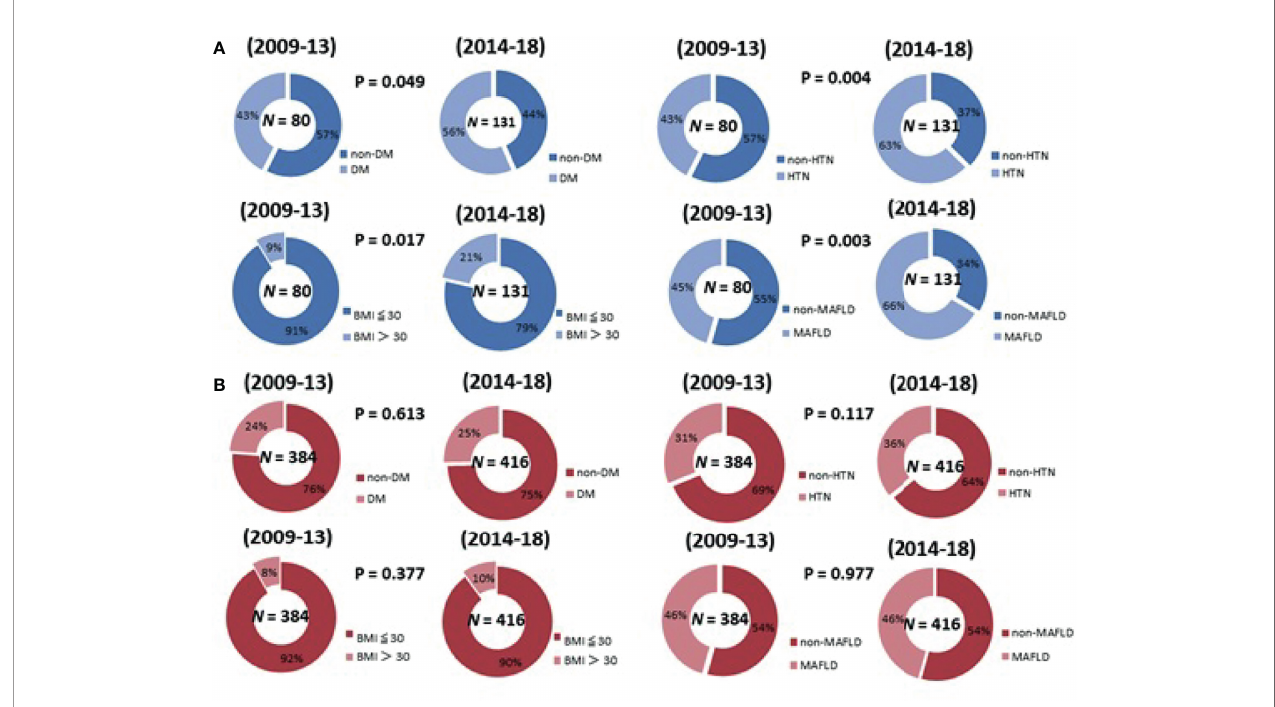
FIGURE 2 | The change of the proportion of metabolic disorders in 2009-2018 in patients with (A) NBNC-HCC patients (B) CHB-HCC patients.